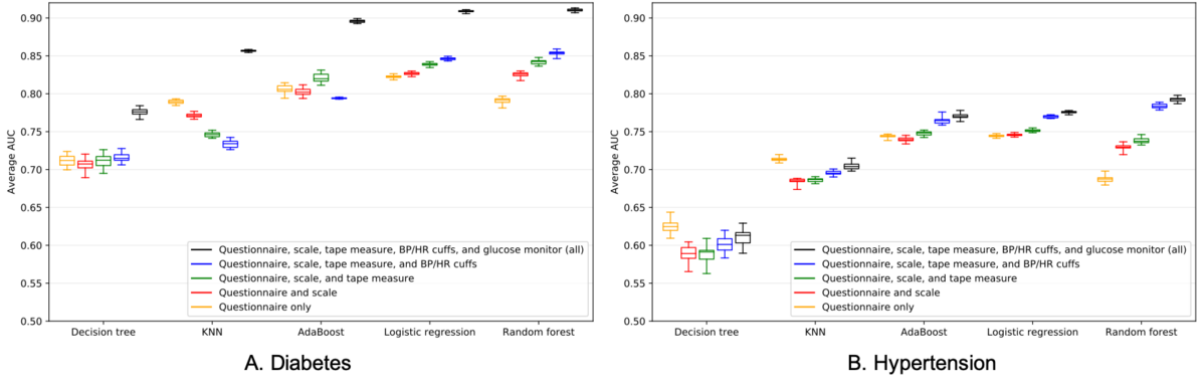
Figure 3. Area under the curve (AUC) distributions for 5 risk stratification models and 5 different features sets. A. Including a glucose monitor had the largest effect on diabetes risk stratification, increasing average AUC by more than 0.05 for all models. B. Including blood pressure/heart rate cuffs had the largest effect on hypertension risk stratification, increasing the average AUC by up to 0.05. BP: blood pressure; HR: heart rate; KNN: K-nearest neighbors